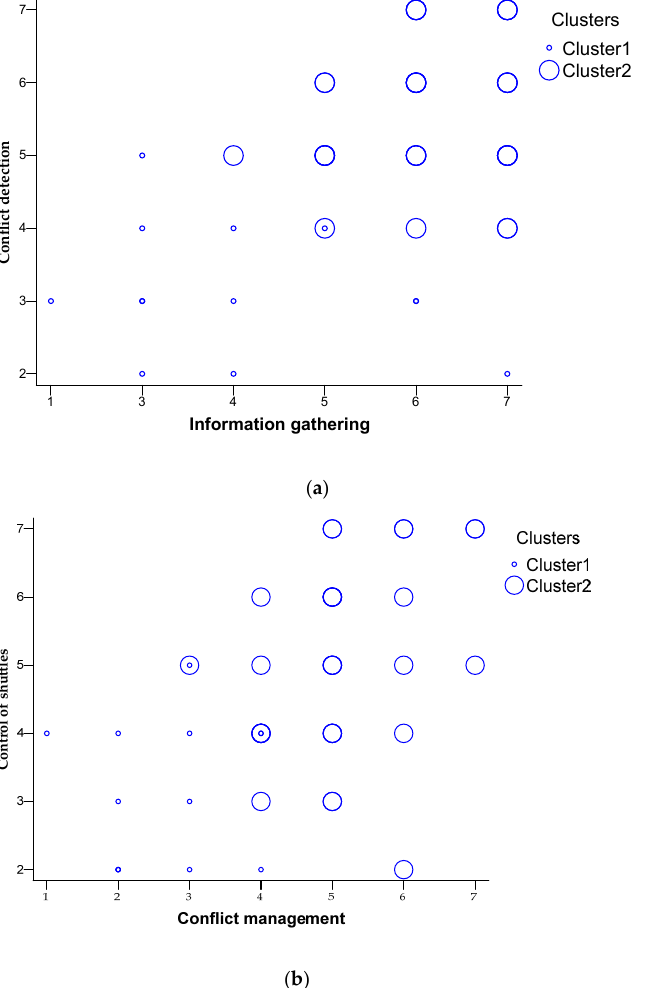
Figure 12. Graphical representation of the clusters formulated from the subjective evaluation of the shuttles KHC regarding conflict detection, conflict management, and authority management. According to the KH of the shuttles, the result shows a significant difference between cluster 1 and cluster 2 in the score achieved. Participants who had better evaluated the KH of the shuttles are those who obtained the highest score. The participants who better eval- uate their own KHC and that of the shuttles are those who were those who felt that the workload was less, that they thought they were sufficiently trained, and that the experi- mental environment was not too complex. In addition, regarding the KHC shuttle, the participants who gave a better evaluation were those who used the assistance system (sim- ulation support) the most (Table 8). The descriptive statistics reveal that most participants (58%) in cluster 1 of shuttles KH functions had access to the assistance system and 60% of participants in cluster 2 did not. Most participants in cluster 1 are frequent gamers (46%) and most of them in cluster